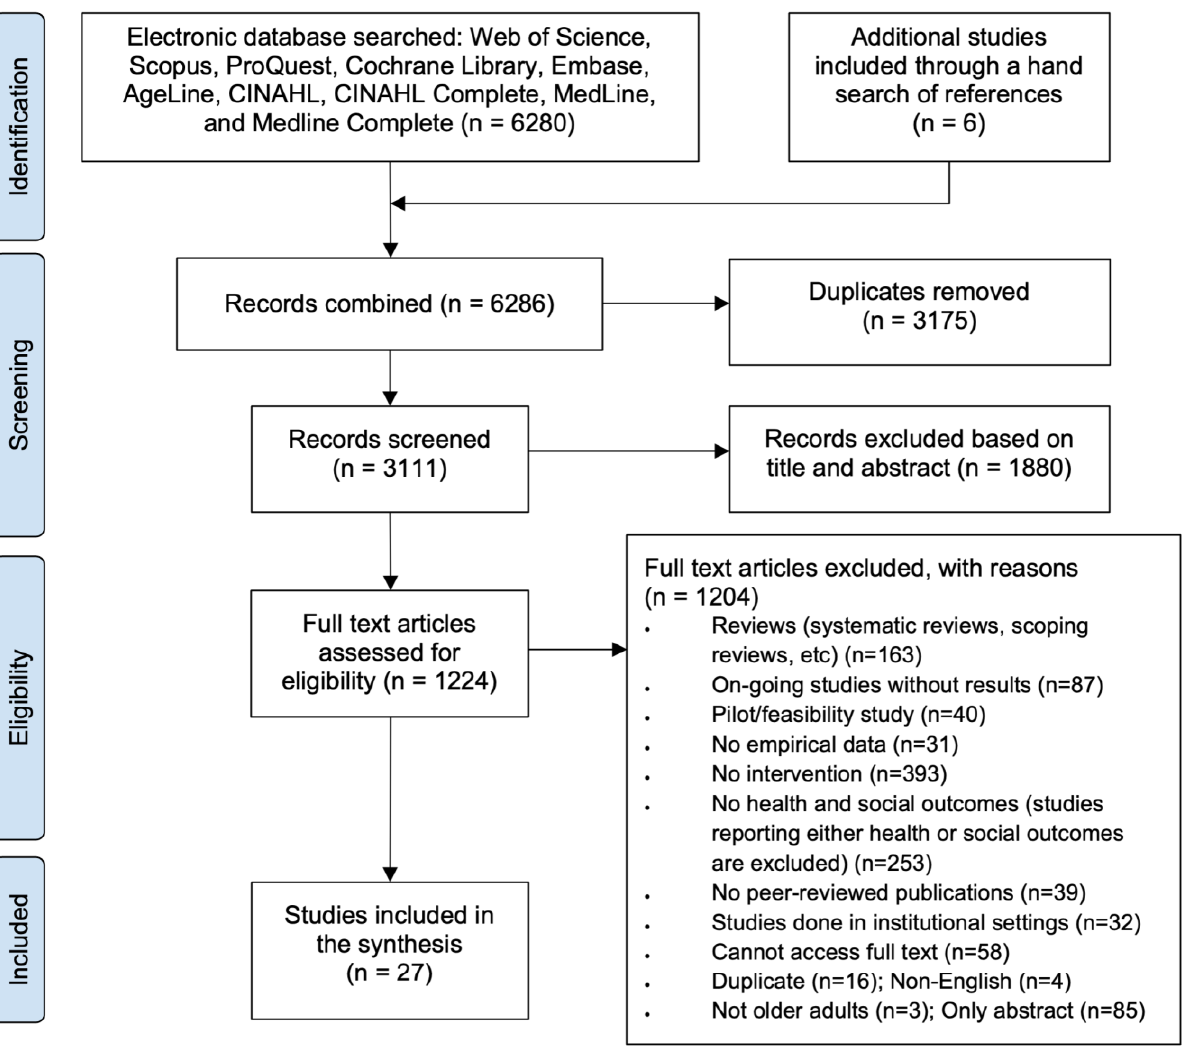
Figure 1. Study selection flow diagram based on PRISMA.